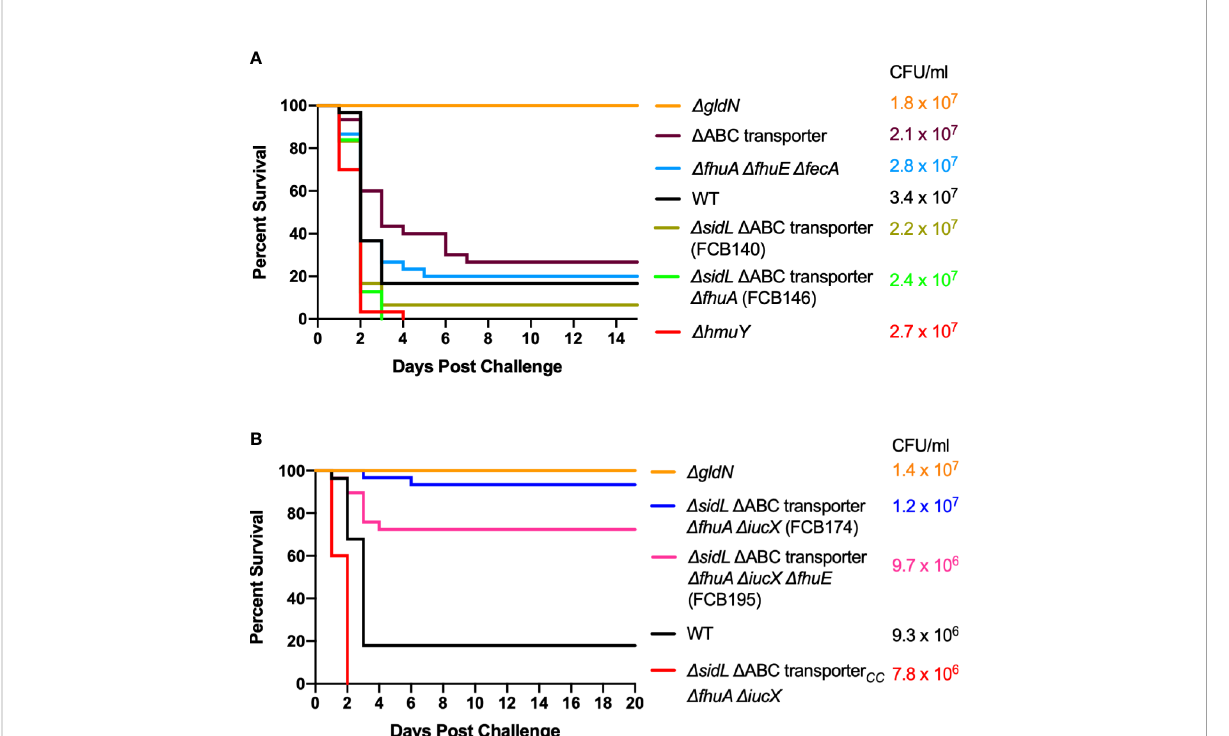
FIGURE 8 Virulence of F. columnare wild type and iron utilization mutants toward rainbow trout fry. (A) Wild type (black), D gldN (orange), D hmuY (red), D ABC transporter (purple), D fhuA D fhuE D fecA (blue), D sidL D ABC transporter (olive), and D sidL D ABC transporter D fhuA (green). The fi nal challenge concentrations for each strain are shown in the corresponding color. (B) Wild type (black), D gldN (orange), D sidL D ABC transporter D fhuA D iucX (FCB174) (blue), FCB174 chromosomally complemented with the ABC transporter genes (red), and D sidL D ABC transporter D fhuA D iucX D fhuE (FCB195) (pink). Signi fi cant differences in the percent survival for fi sh challenged with F. columnare were seen between WT and FCB174 (P < 0.0001), WT and FCB195 (P < 0.0001), and FCB174 and FCB174 chromosomally complemented with the ABC transporter genes (P < 0.0001). The difference between FCB174 and FCB195 was not signi fi